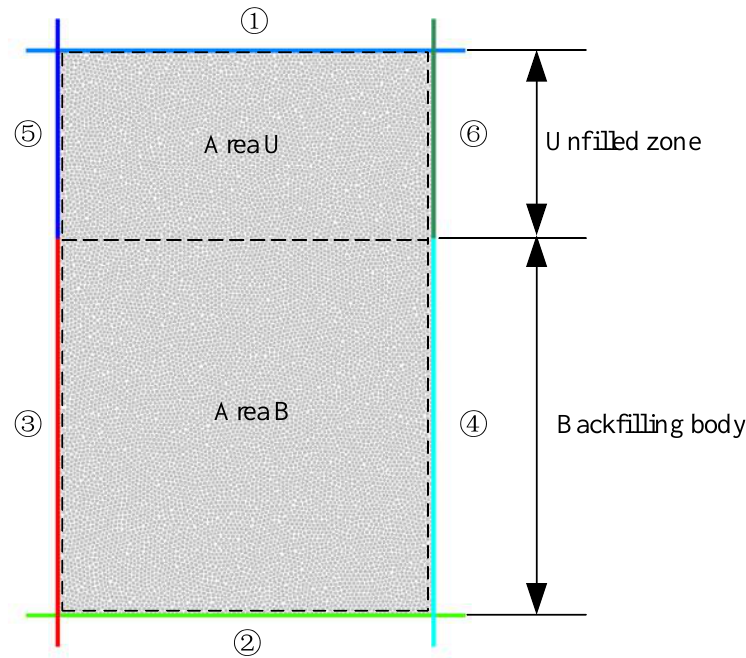
Figure 3. Numerical simulation model of coal pillars under different backfill body height. Table 2. Strength and deformation characteristics of coal